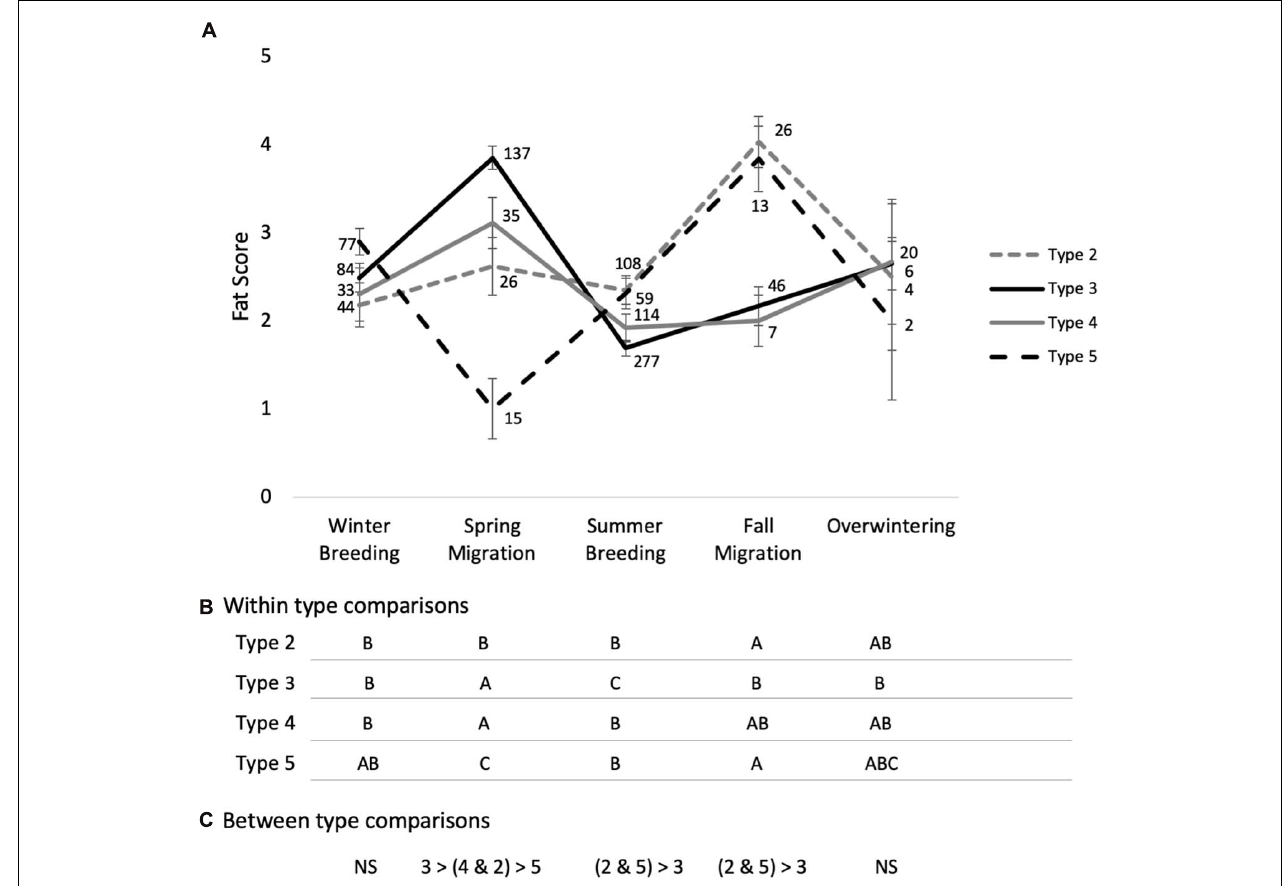
FIGURE 3 | Fat deposits by life cycle stage in free-living red crossbill ecotypes 2, 3, 4, and 5. Fat deposits increased from winter breeding to spring migration in types 3 and 4, but declined or didn’t change in pine-associated types 5 and 2, respectively (A) . The pattern flipped between summer breeding and fall migration, where pine-associated types showed larger fat deposits than types 3 and 4. There were no type differences in winter. Comparisons of life cycle stages within types (B) . Different letters indicate life cycle stages that are significantly different based on Tukey comparison of means P < 0.05. Comparison between types within life cycle stages based on Tukey comparison of means P < 0.05 (C) . Sample sizes given in (A) , error bars denote